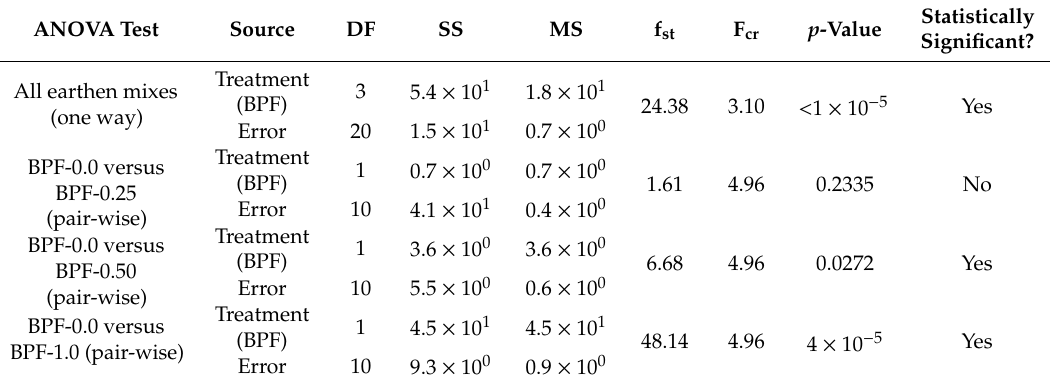
Figure 16. Dry abrasion coefficient results of each earthen mix.